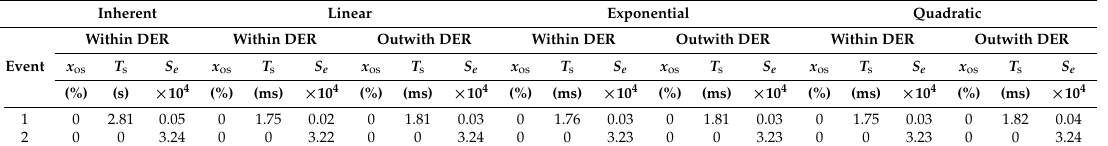
Table 5. Dynamic response performance indicators for the two events under the islanded mode of